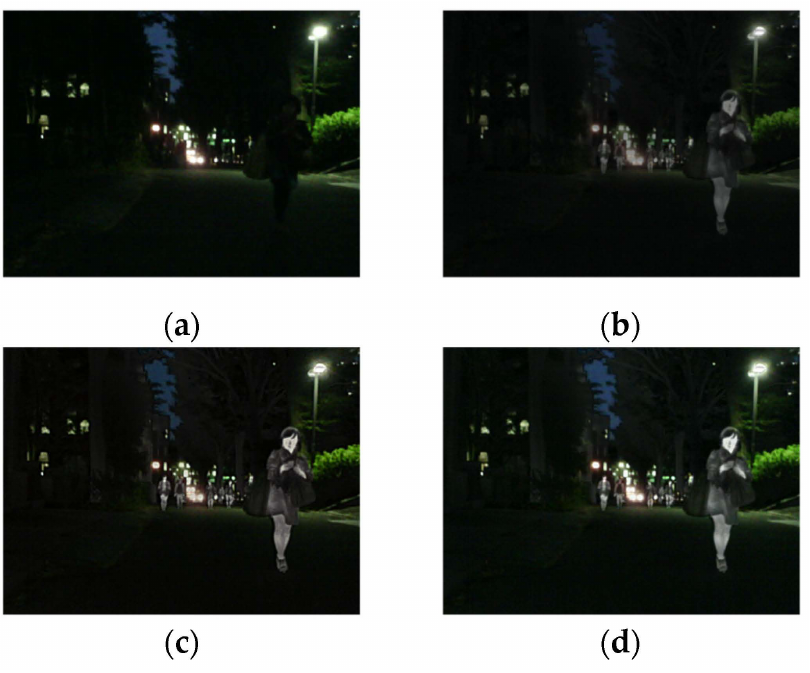
Figure 9. ( a ) a visible original image; ( b ) fused image using Densefuse; ( c ) fused image using Lpfuse; ( d ) fused image using our methods.